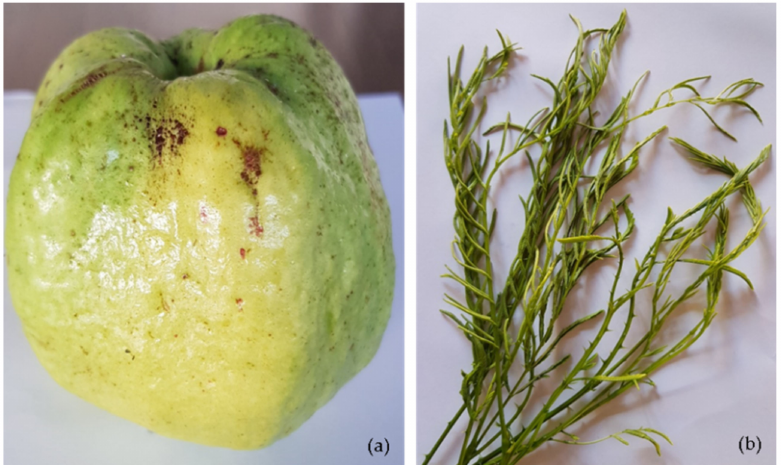
Figure 1. Frequent consumption of ( a ) guava fruit and ( b ) Acacia pennata vegetable by older adults living in northern Thailand was associated with reduced risk of physical